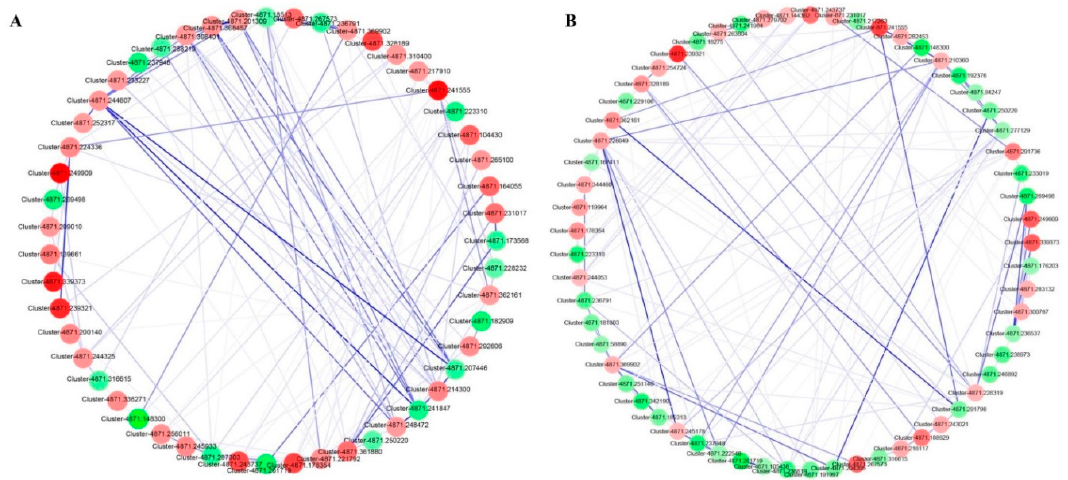
Figure 3. Illustration by STRING analysis of protein–protein interactions (PPIs) networks in sugarcane cultivars LCP85–384 ( A ) and ROC20 ( B ) inoculated with X. albilineans . Blue lines connect proteins of the PPI networks and the darker blue colors indicate higher core PPI values. The red and green colors indicate the upregulated and downregulated DEPs, respectively. Darker colors of circles are related to higher log 2 Fold Change values of DEPs. The protein IDs were listed in Supplementary Tables S2 and S3.